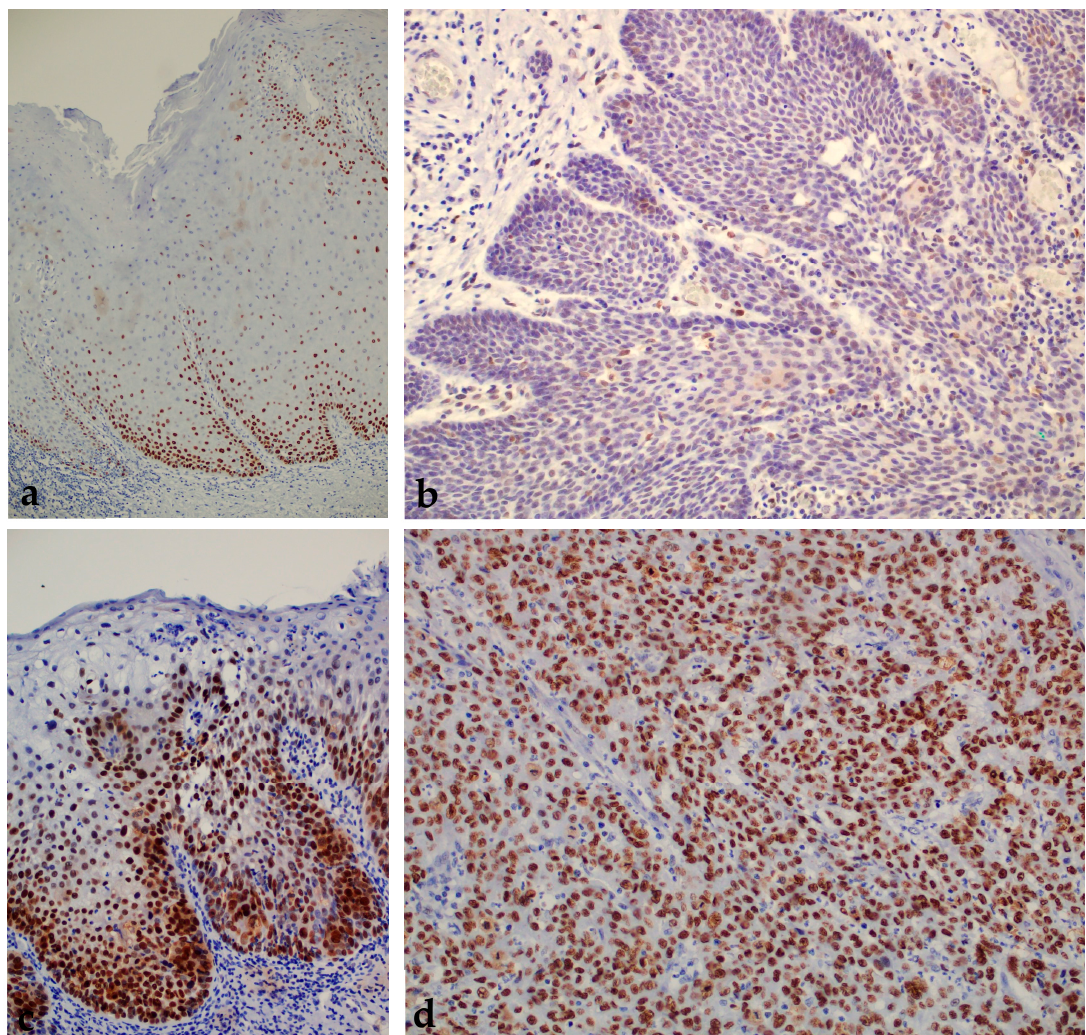
Figure 4. Moderate expression of p53 protein in oral leukoplakia according to the Allred scoring system (+). Magnification 100 × ( a ). OSCC showing moderate p53 protein immunoreactivity according to the Allred scoring system (+). Magnification 200 × ( b ). Oral erythroplakia with severe dysplasia and strong p53 protein expression in the dysplastic part of the affected epithelium according to the Allred scoring system (++). Magnification 200 × ( c ). Strong immunohistochemical expression of p53 in OSCC according to the Allred scoring system (++). Magni fi cation 200× ( d ).